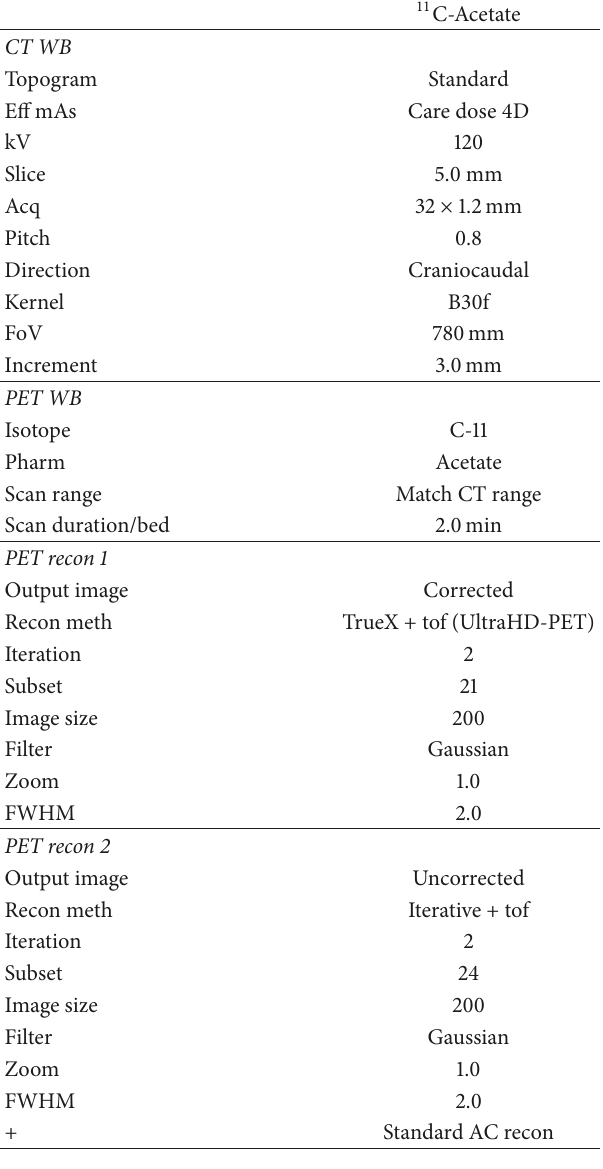
Table 1: The parameters of acquisition and